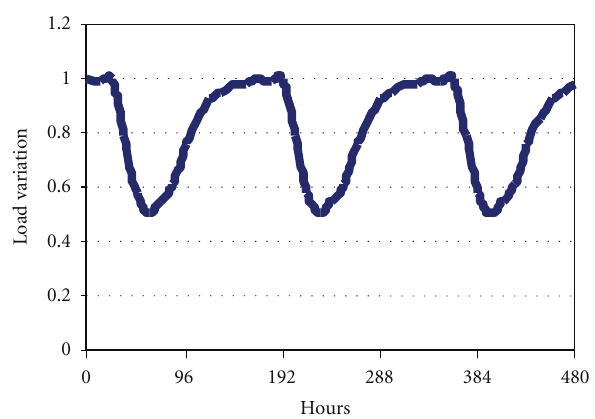
Figure 7: Typical Change of E ffi ciency with part load for 3 di ff erent industrial gas